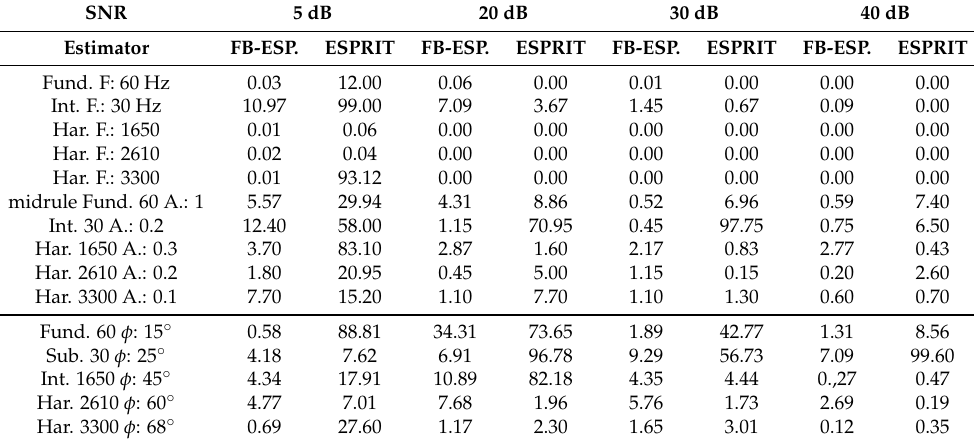
Table 3. Percentage error (%) of signal s 1 ( t ) parameters’ estimated with 1000 runs for the FB-ESPRIT